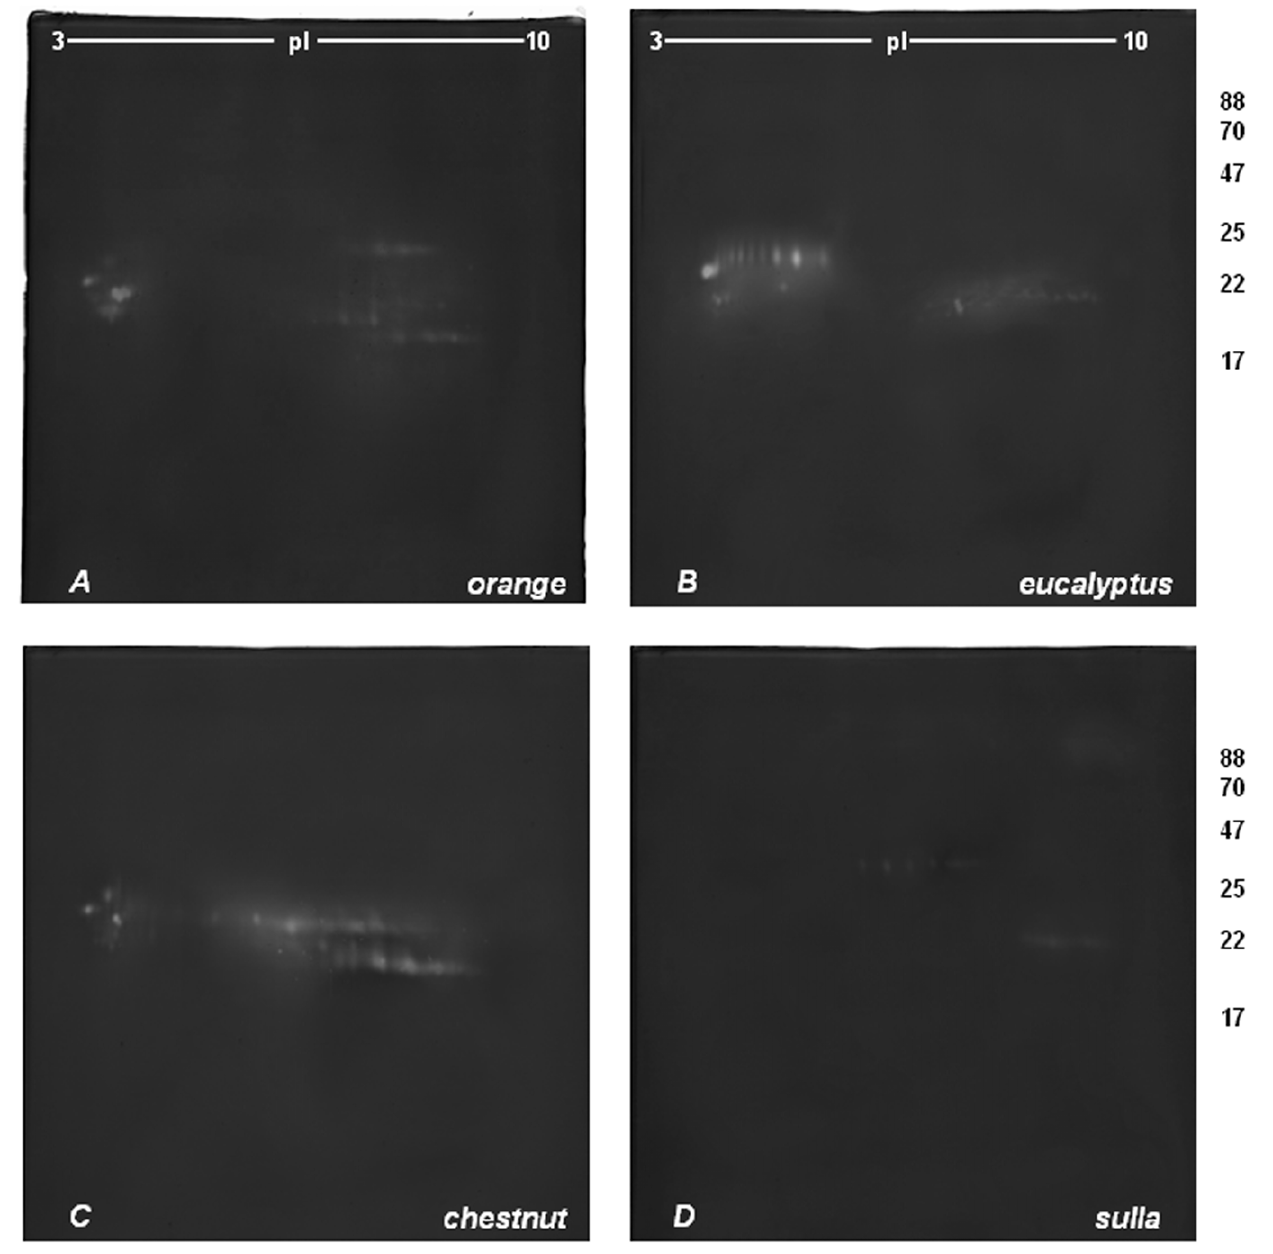
Figure 3. 2-D zymography (2-DZ) of the proteolytic activities present in honey PZ1 extracts. Proteolytic activities were detected by 2-D zymography on gels copolymerized with gelatin. Gels: A ( orange honey), B ( eucalyptus honey), C ( chestnut honey) and D ( sulla honey). 80 m g of proteins were applied to each gel.